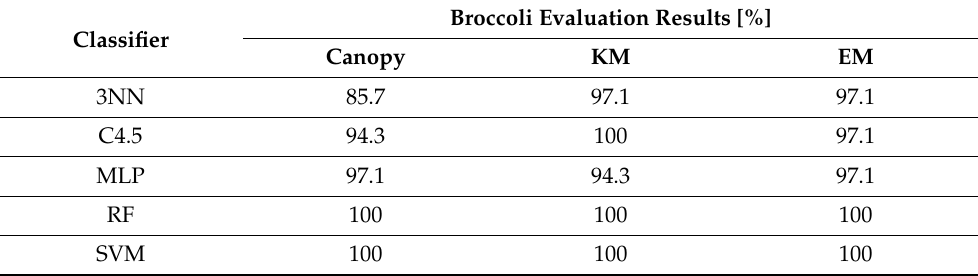
Table 13. The assessment of clusterization of the broccoli case.